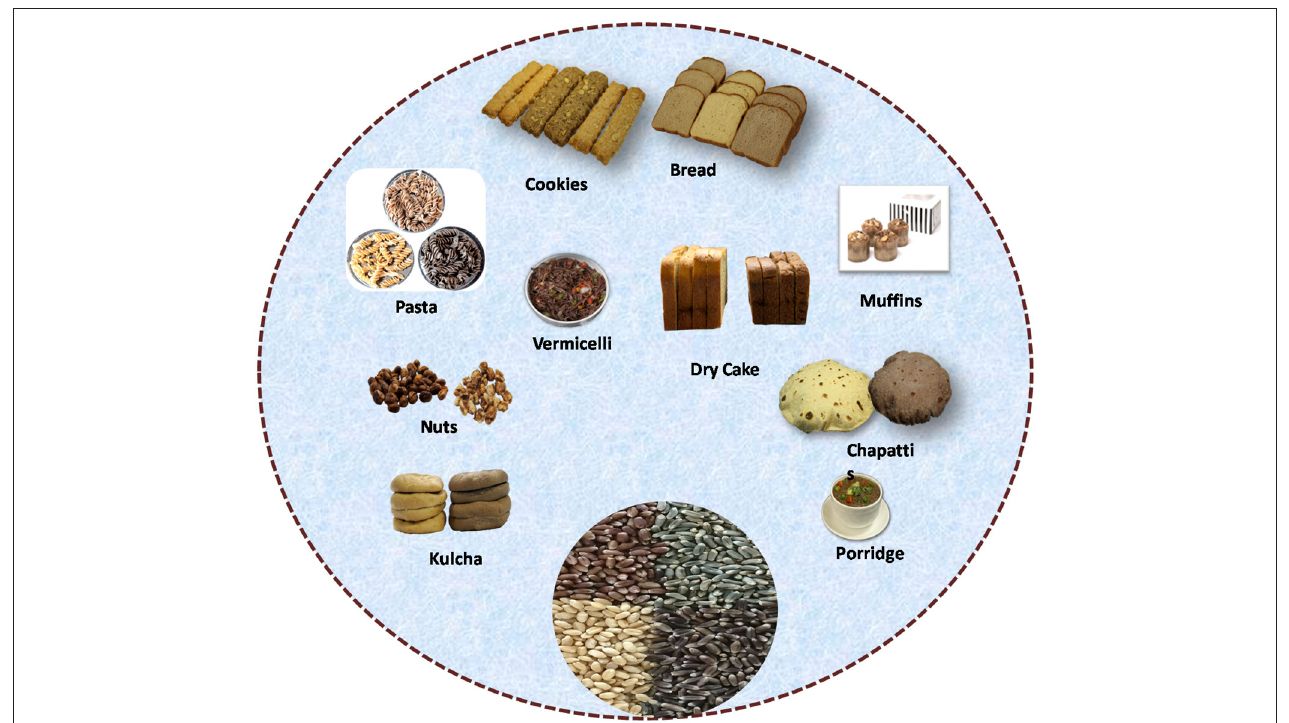
FIGURE 4 | Development of different colored wheat products with high nutritional